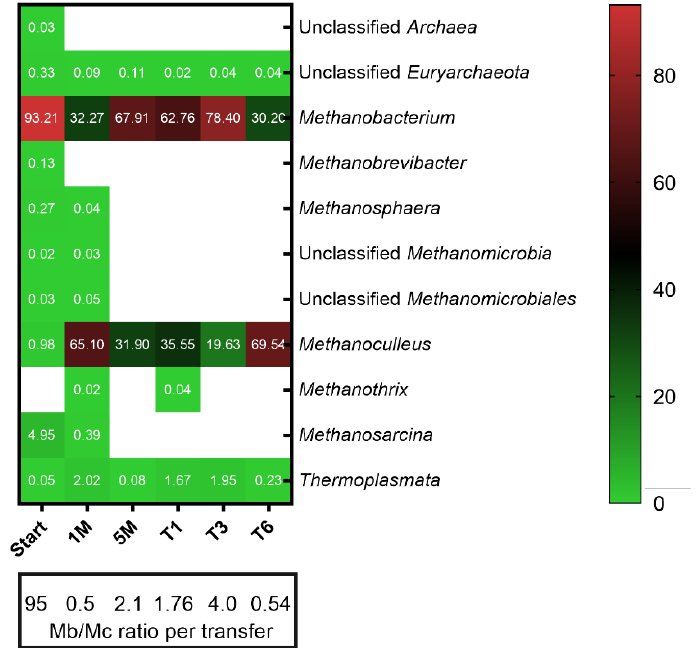
Figure 2. Methanogenic community structure in different stages of the enrichment. Taxa with a relative abundance less than 0.01% were filtered out from all samples. Numbers represent the relative abundance in percent and blank space indicates the absence of the respective taxa. The ratio of the most dominant methanogens, Methanobacterium (Mb) and Methanoculleus (Mc), among transfers is shown. Mean values of three biological replicates are presented for T1, T3 and T6 whereas single values are shown for Start, 1M and 5M.